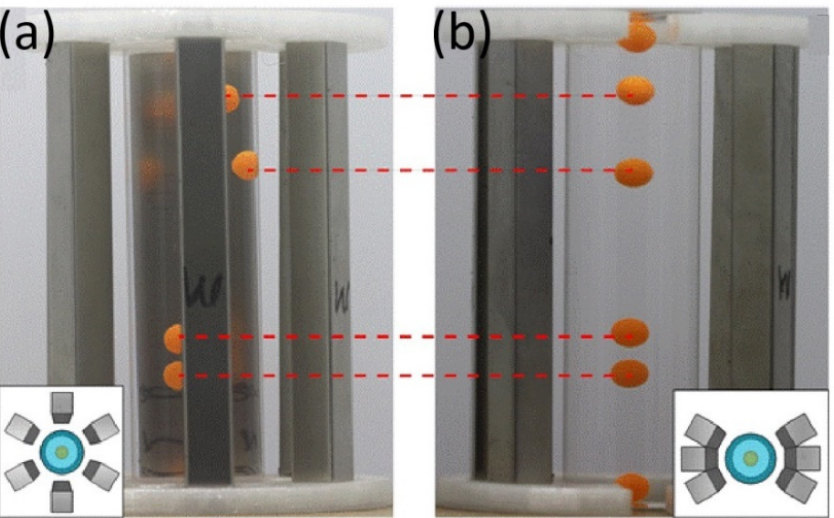
Figure 7. Captured photographs of polystyrene beads levitated in 6-magnet M-MagLev system with ( a ) C 6 -symmetry distribution of magnets and ( b ) C 2 -symmetry distribution of magnets. The insets are the distribution diagram of six magnets. The red dashed lines represent the di ff erent positions of the same ball under di ff erent magnetic distributions.